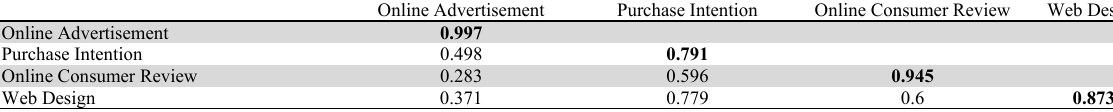
Results of Discriminant Validity Test (Fornell Lacker Criterum)